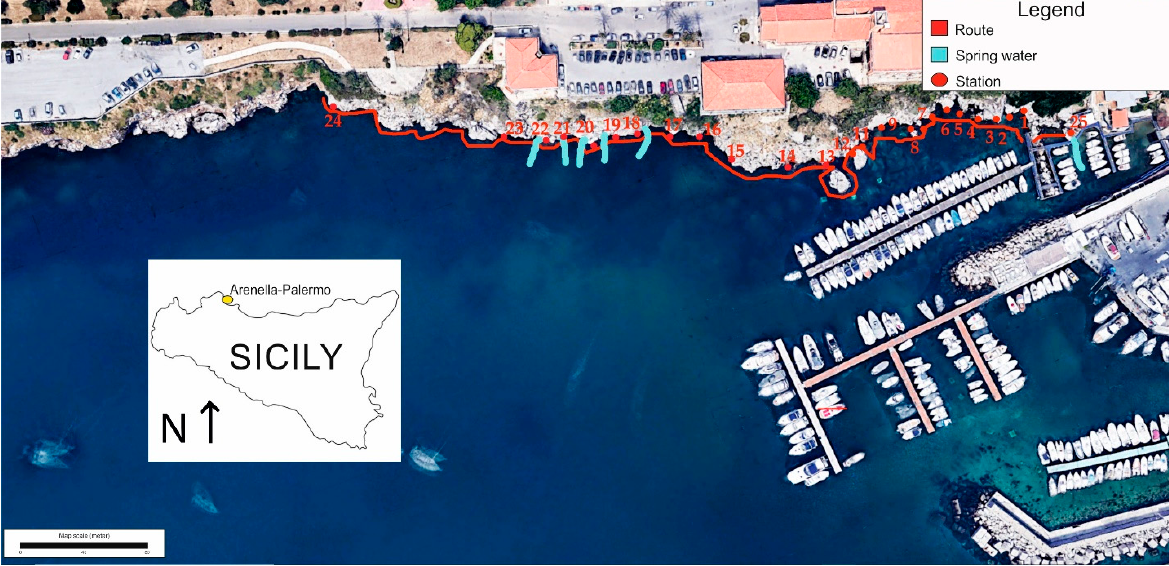
Table 3: The morphometric parametres of MTNs in the short stretch at the Arenella harbour (Palermo).